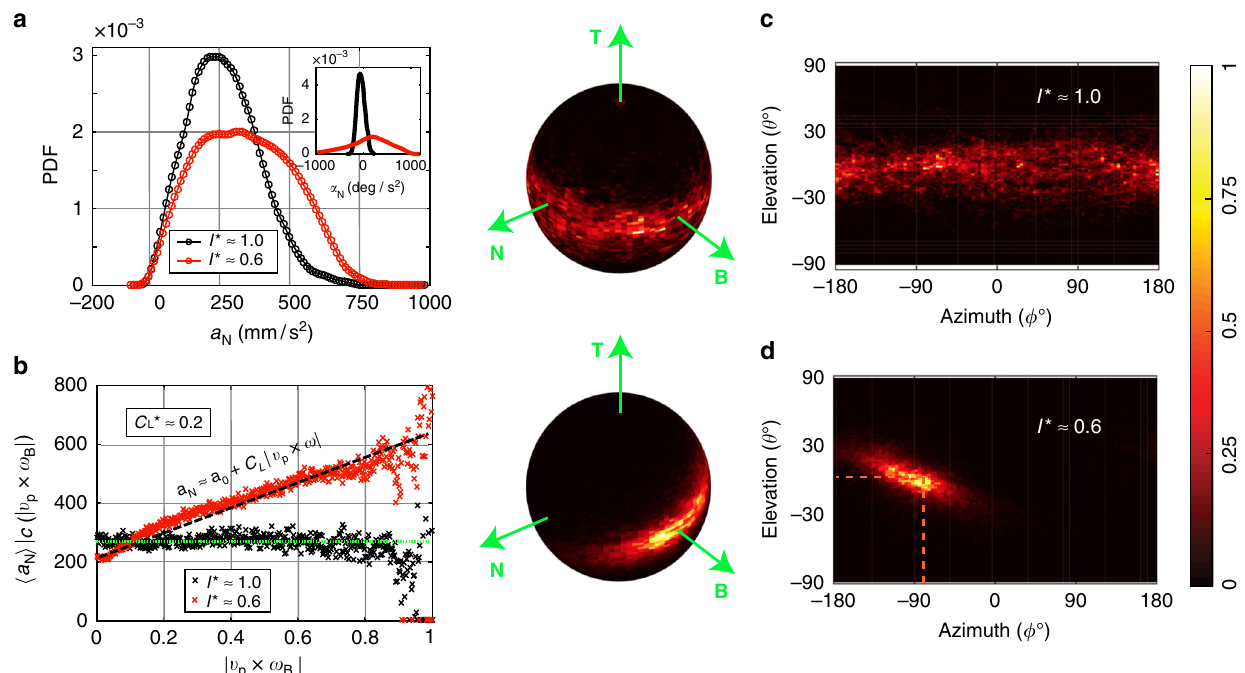
Fig. 3 Translational acceleration statistics and rotation alignment statistics of buoyant spheres in turbulence. a Probability density function (PDF) of the centripetal acceleration a N for the high (in black) and low MoI (in red) spheres rising through a turbulent fl ow at Re λ ≈ 300. Note that a N is directed along (cid:7) (cid:8) N of the TNB coordinate system. Inset shows the PDF of the angular acceleration α N for the two spheres. b a N h ij c , the acceleration conditioned on the ´ ω (cid:9) (cid:9) magnitude of lift force 32,43 v for the high (in black) and low MoI (in red) spheres. The dashed line shows the prediction for the enhancement of p (cid:9) (cid:9) a C ´ ω h ij (cid:9) (cid:9) . The dotted line shows the nearly constant value of a c due to a rotation-induced lift force N L v p histograms showing the orientation of the angular velocity vector ω in the TNB coordinate system for the c high and d low MoI spheres in the turbulent fl ow. The planar histograms (right half of c , d ) show the same data as the spherical histograms (left half of c , d ), but in terms of the elevation θ and azimuth ϕ angles. The particle rotation aligns strongly with B for the low MoI sphere, while it is spread in the NB plane for the high MoI